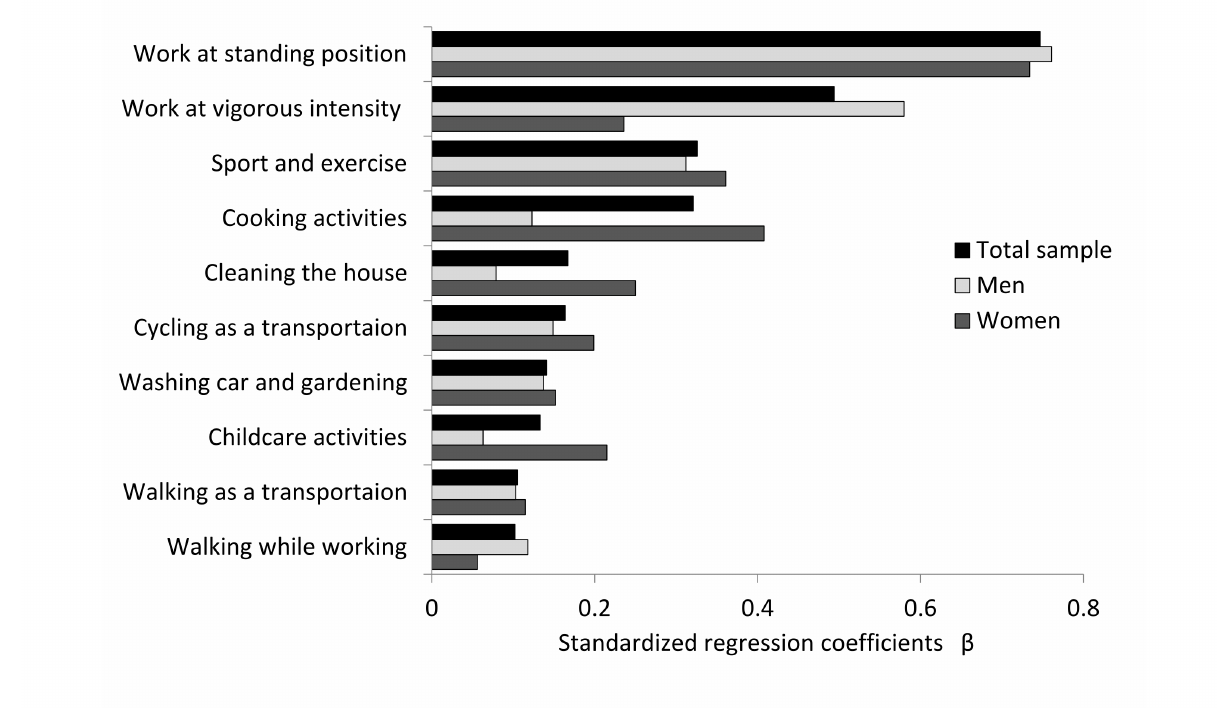
Figure 5. Multiple regression analysis for moderate-to-vigorous physical activity in men and